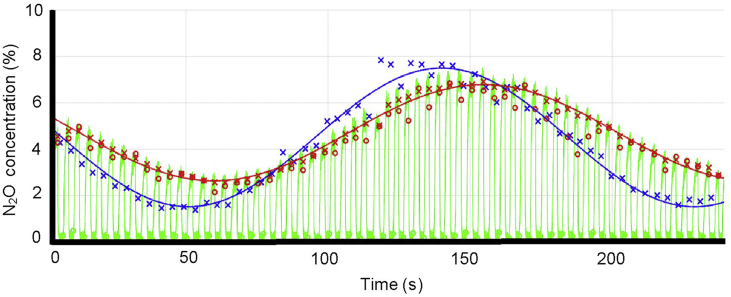
A typical example of recorded data, with inspired N2O concentration oscillating sinusoidally around a fixed mean (4%), with a predetermined amplitude (3%) and period (180 s). Green line is the expired N2O concentration; the blue and red crosses are the N2O concentrations in inspired gas and end-tidal gas, respectively; the blue and red lines are the inspired and expired N2O sinewaves, respectively (reproduced from Bruce and colleagues15).